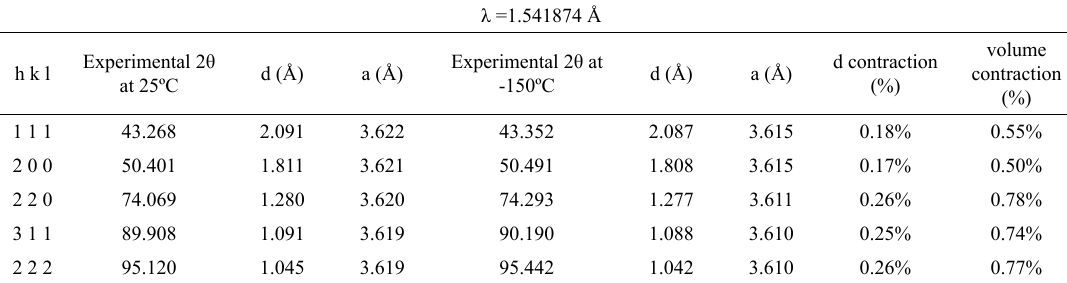
Table 3. Calculated volumetric contraction based on lattice parameter for X-ray diffraction peaks of silver. h k l